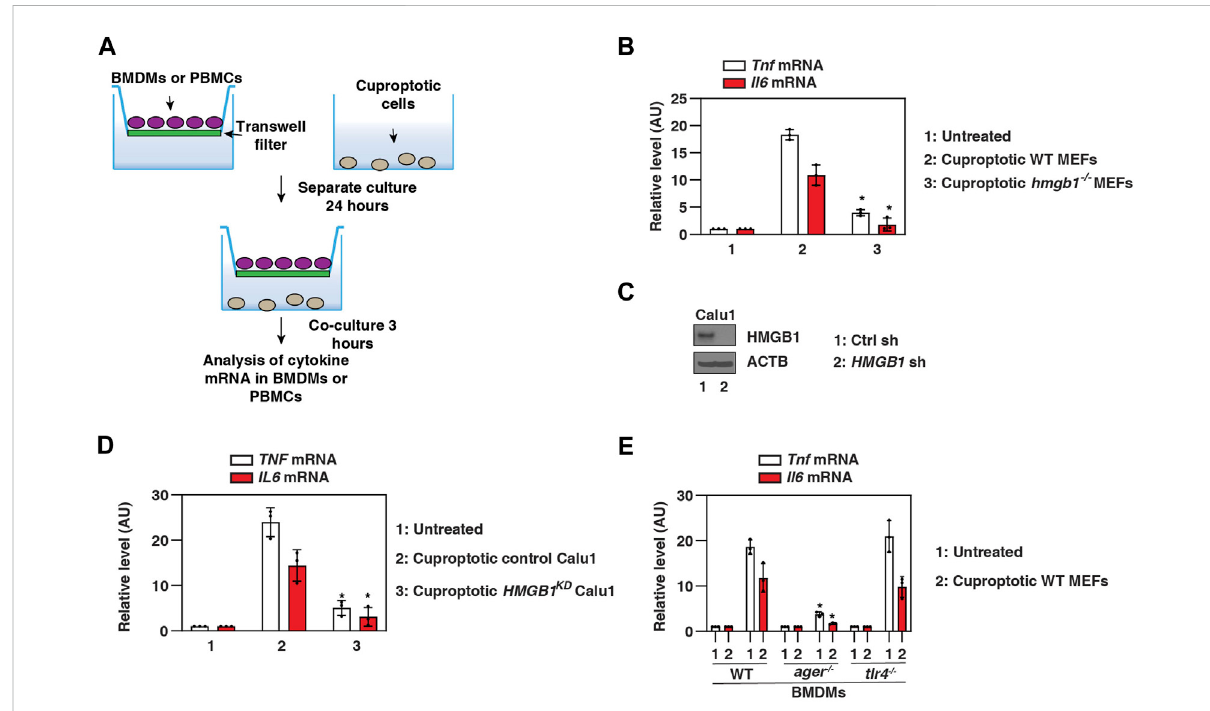
FIGURE 4 HMGB1 triggers AGER-dependent in fl ammation caused by cuproptotic cells. (A) Scheme of transwell systems for co-cultures of immune cells and cuproptotic cells. (B – D) Our qPCR assays show that TNF and IL6 mRNA levels in BMDMs or PBMCs were reduced in response to cuproptotic hmgb1 − / − MEFsorHMGB1-knockdownCalu1cells( n =3;* p < 0.05versuscontrolgroup, two-wayANOVA).(E)AqPCRassayshowsthatcuproptotic wild-type MEF-induced upregulation of Tnf and Il6 mRNA was inhibited in ager − / − BMDMs, but not in tlr4 − / − BMDMs ( n = 3; * p < 0.05 versus WT group, two-way ANOVA). The results in (B,D,E) are representative of those from three independent